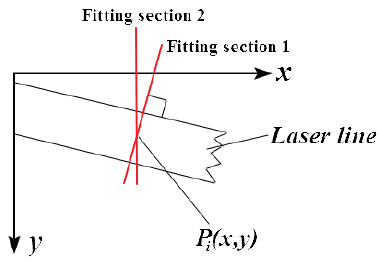
Figure 11. Selection of fitting sections.